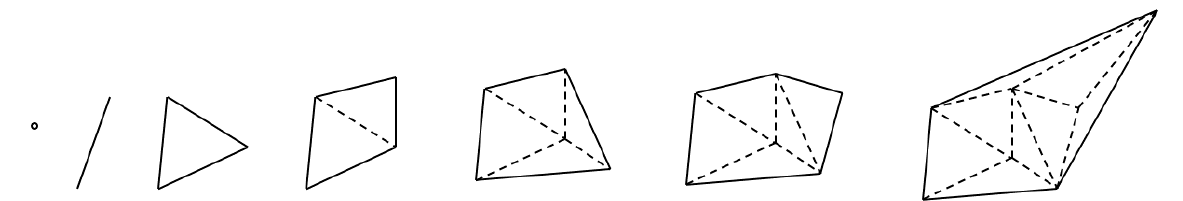
Figure 5: Illustrative example for the generation of the convex